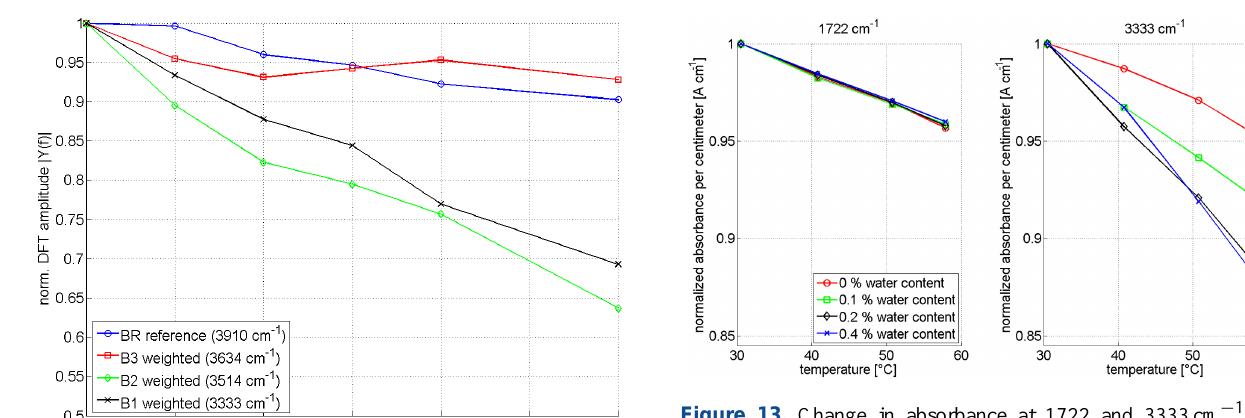
Figure 13. Change in absorbance at 1722 and 3333cm − 1 for aged synthetic motor oil with increasing water content (0, 0.1, 0.2, 0.4wt.%, respectively) and increasing